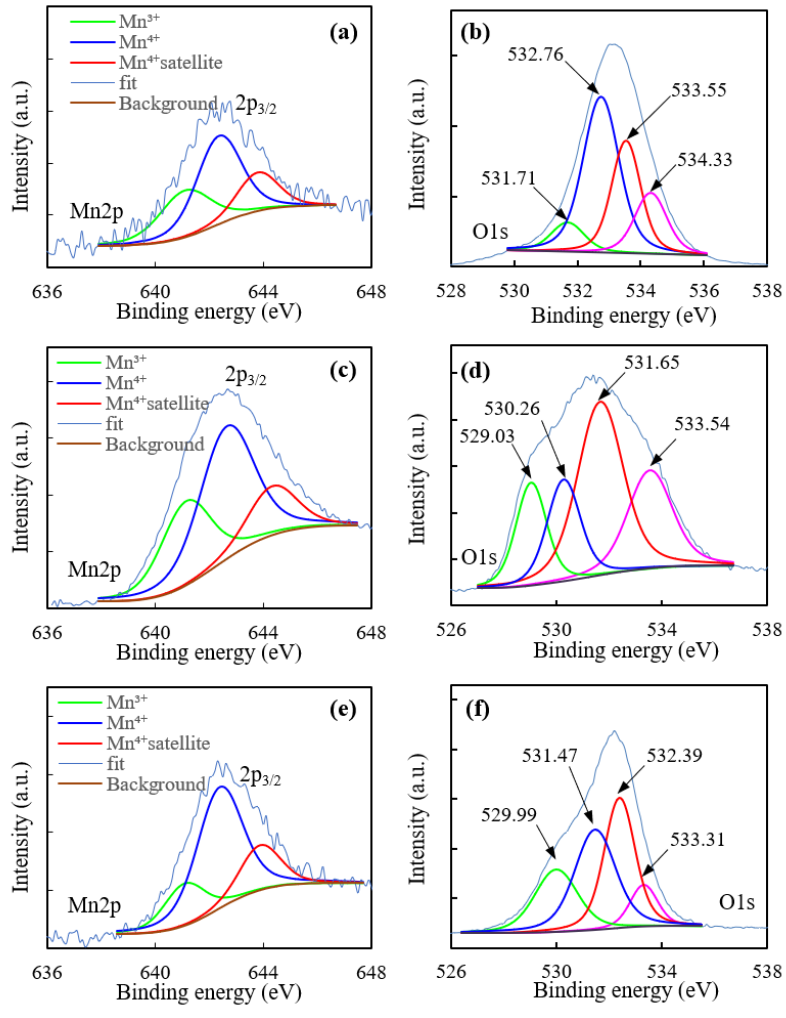
Figure 6. Mn2p and O1s XPS spectra for the Mn 91.1 Cu 8.9 /SiO 2 –IWI ( a , b ); Mn 91.1 Cu 8.9 /SiO 2 –UH ( c , d ); and Mn 89.9 Cu 10.1 /SiO 2 – AE ( e , f ) catalysts calcined at 350 °C for 3.5 h.